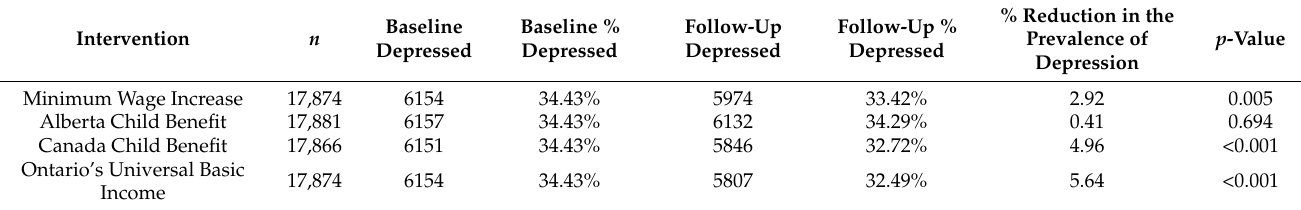
Table 2. Results of agent-based models simulating the effects of four income inequality reducing programs on maternal